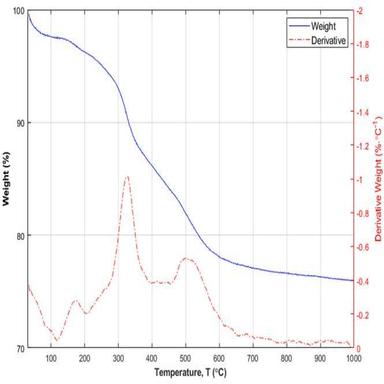
Thermal stability against temperature T for the aerogel composite.